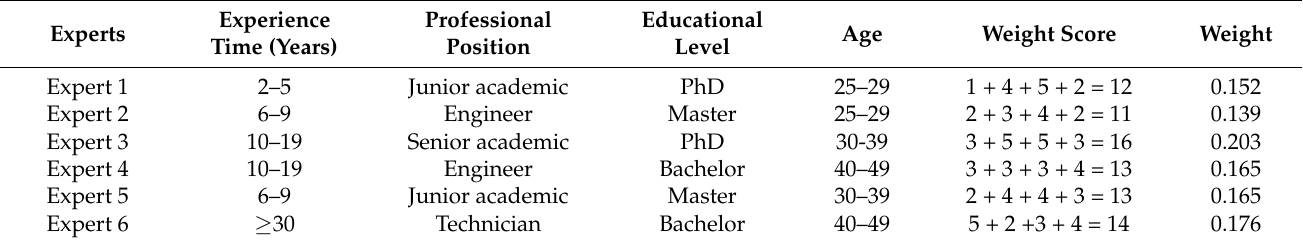
Table 3. Expert Information and